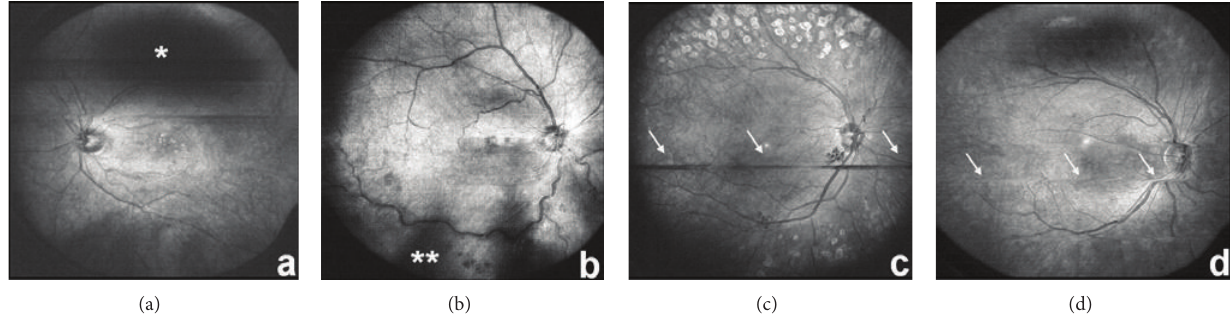
Figure 2: Artifacts of reconstructed en face wide-field fundus images with pupillary shadowing in (a) ( ∗ ) and ciliary shadowing in (b) ( ∗∗ ). Eye blinks result in horizontal black stripes seen in (c) and saccades in misalignments (see (d)) in the reconstructed en face images.